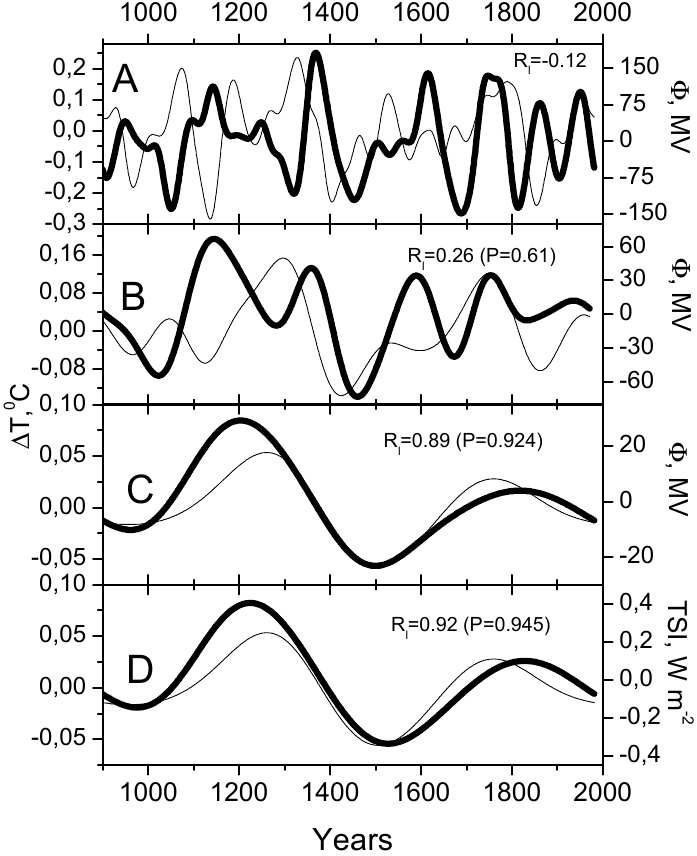
Figure 4. SSA temperature [10] and solar modulation parameter Φ 10 Be in Antarctic ice [12] wavelet filtered in: ( A )—SSA temperature [10] and solar modulation parameter [12] wavelet filtered in century-long (58.1–156.7 years) scale band, ( B )—SSA temperature [10] and Φ [12] wavelet filtered in bi-centennial (186.1–282.4 years) scale band, ( C )—SSA temperature [10] and Φ [12] wavelet filtered in multi-centennial (282.1–427.6 years). ( D )—SSA temperature [10] and TSI [11] filtered in multi-centennial (393.4–548.7 years). Second-order polynomial trends were removed from all series. Thin lines show temperature, thick lines show solar proxies.